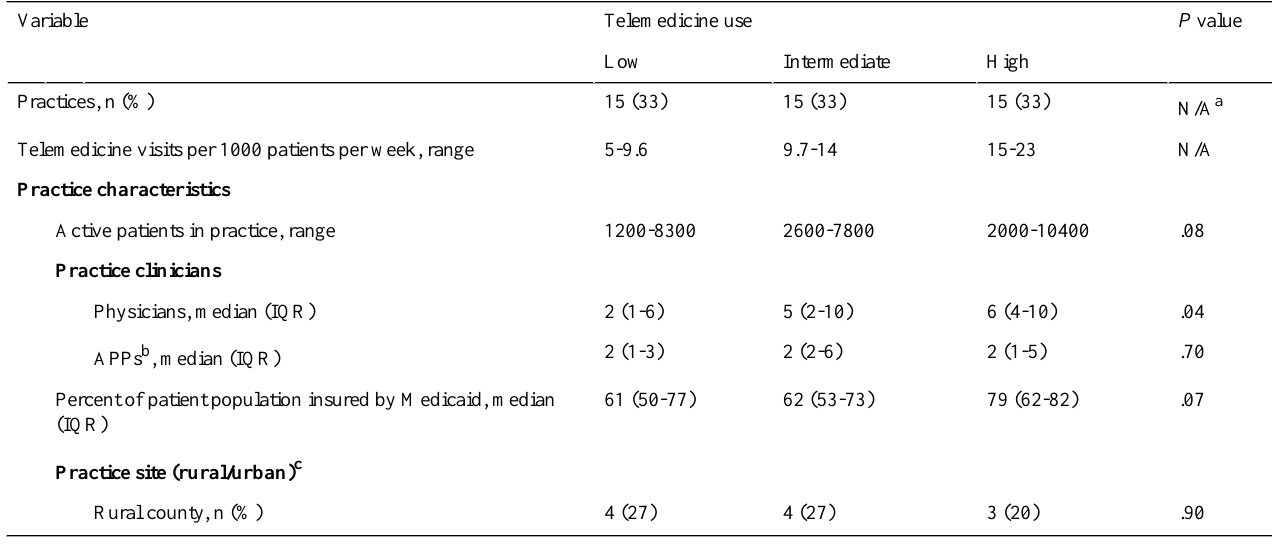
Table 1. Practice characteristics by low, intermediate, or high telemedicine use